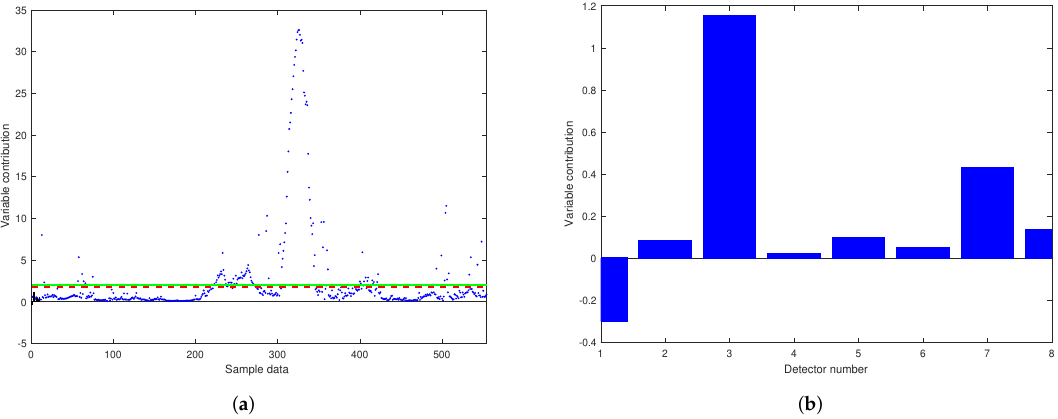
Figure 7. The SPE threshold and contribution graph for matrix X: ( a ) the SPE control limit of X; ( b ) each variable contribution graph of